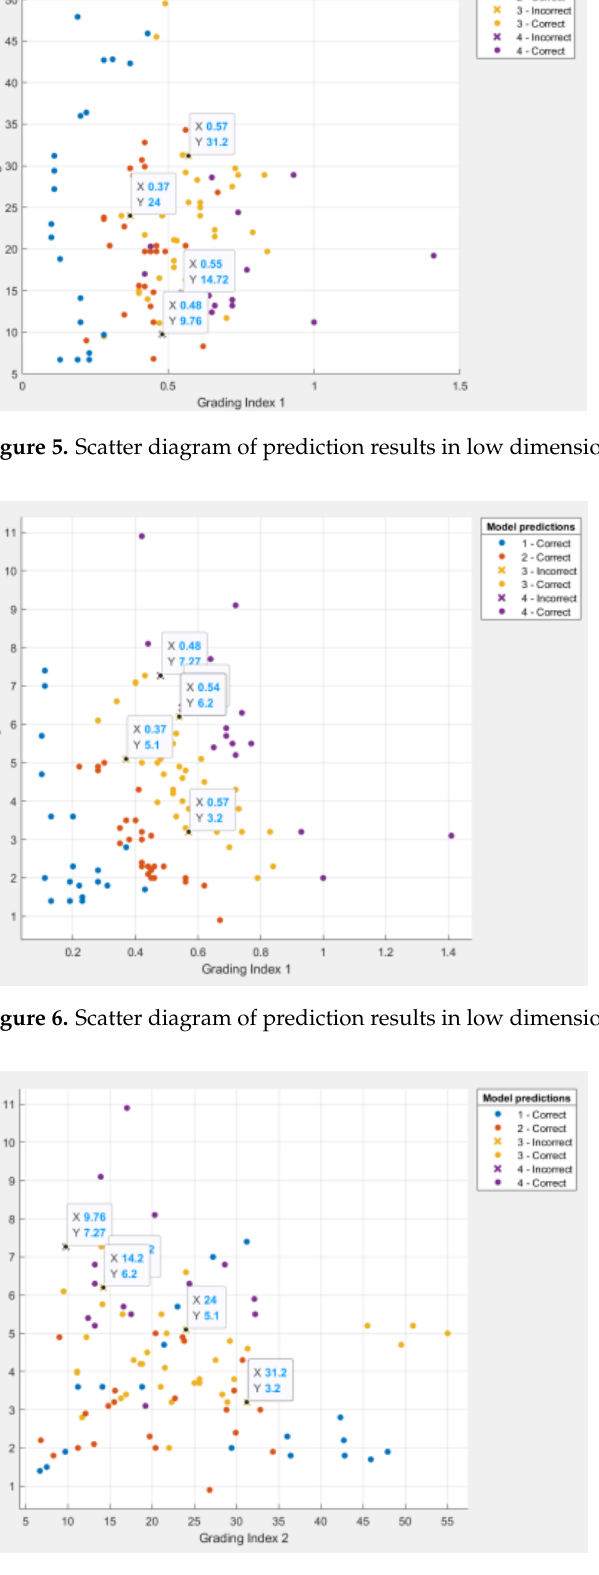
Figure 8. Minimum classification error diagram.